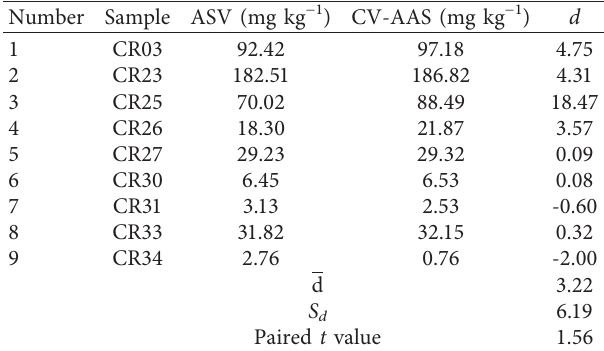
Table 1: Determination of mercury in solid samples by ASV and CV-AAS